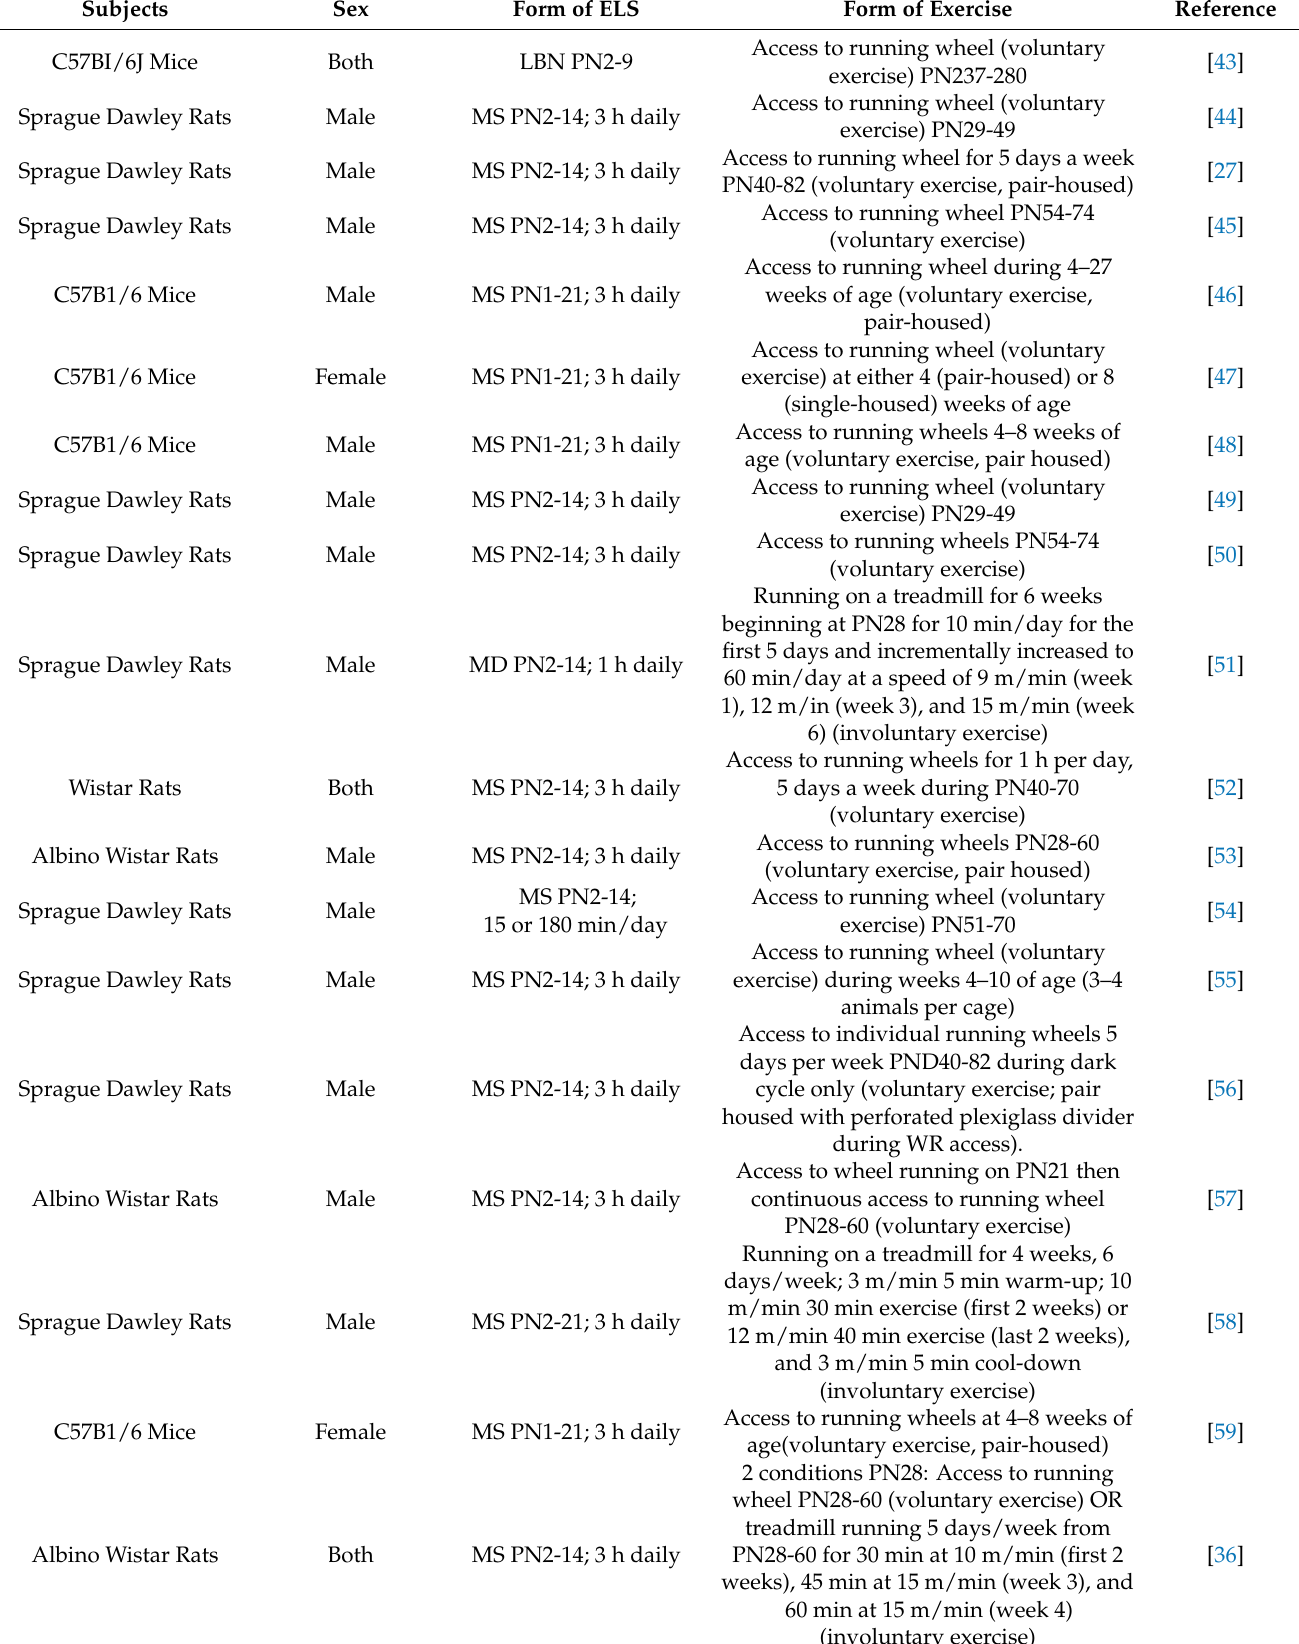
Table 1. Summary of Methods in Currently Published ELS and Exercise Intervention